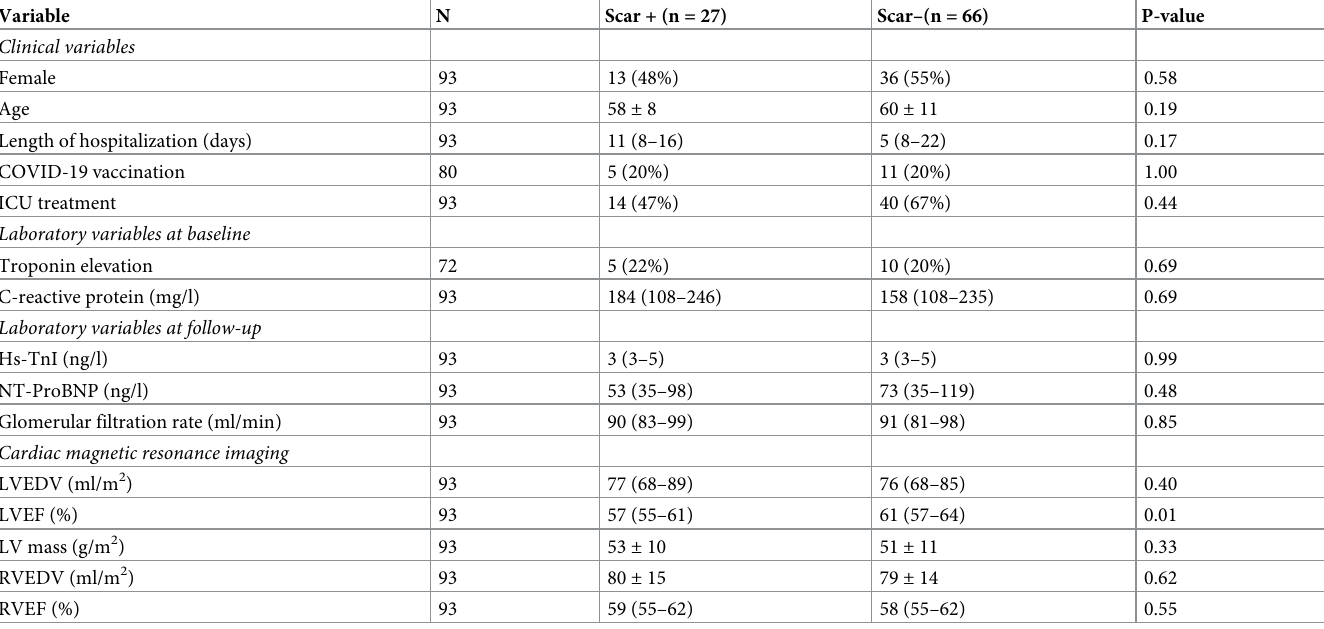
Table 3. Comparison of selected clinical and imaging variables in COVID-19 patients with and without myocarditis scar on follow-up.